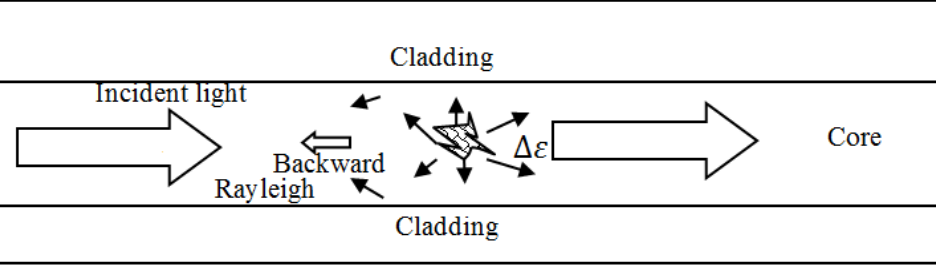
Figure 2. Schematic diagram for the spontaneous Rayleigh scattering